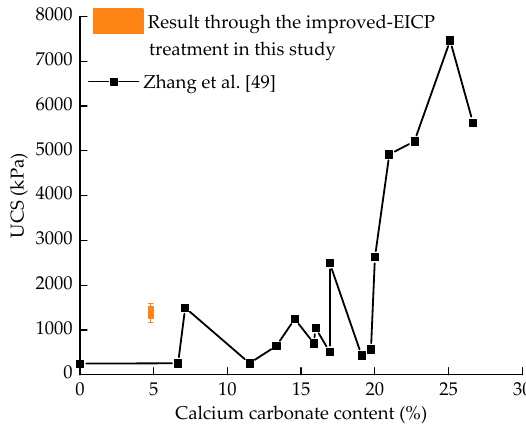
Figure 9. Relationships between UCS and CCC.